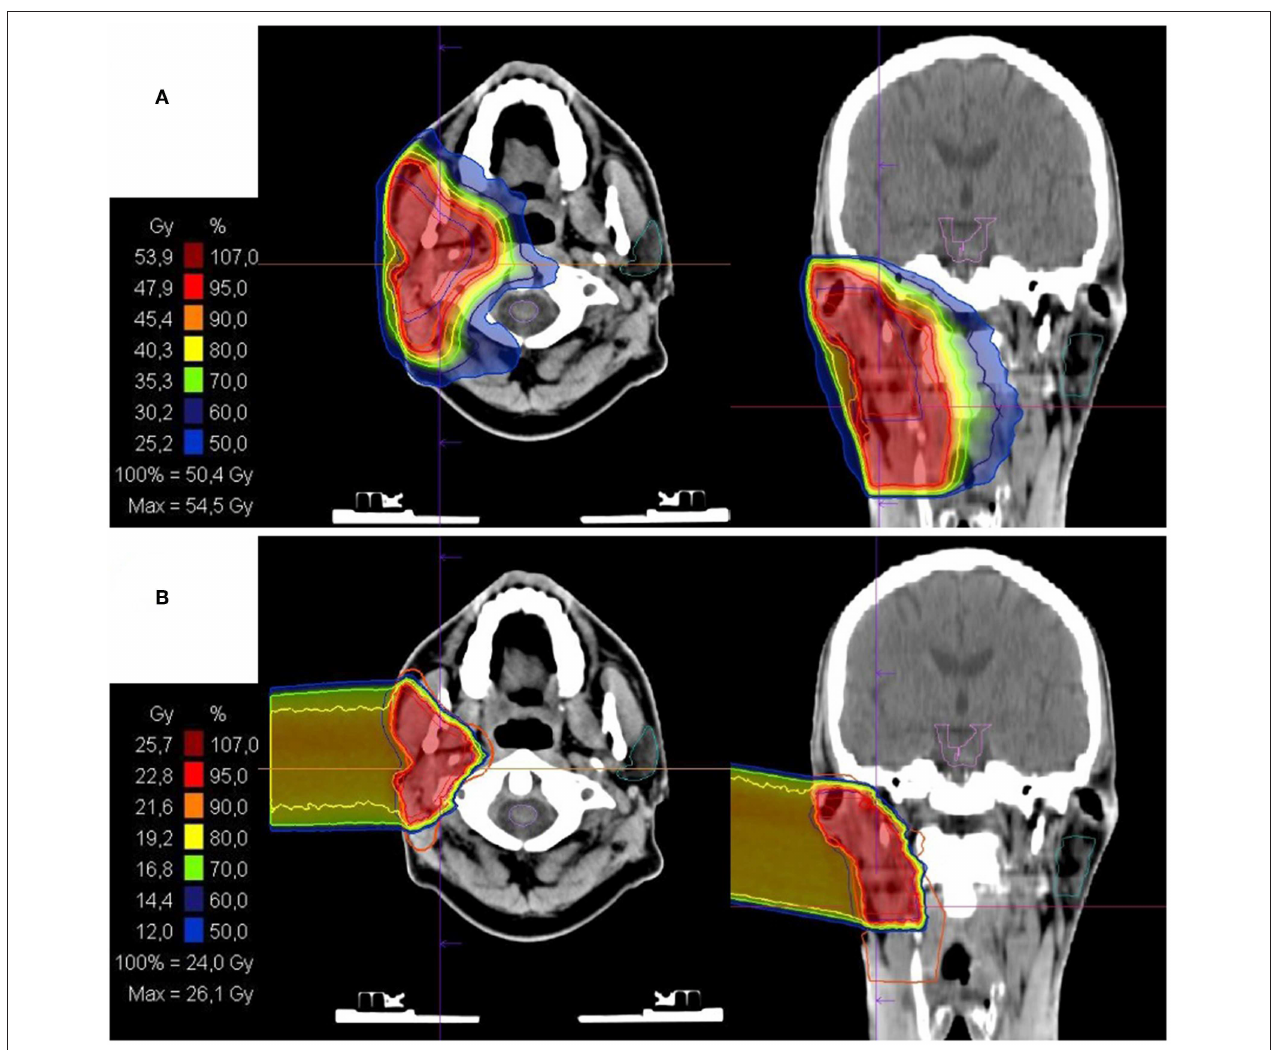
FIGURE 1 | Bimodal radiotherapy treatment plan: (A) intensity modulated radiotherapy (IMRT) base plan with 50Gy in 2Gy/fraction and (B) active raster-scanning carbon ion radiotherapy (CIRT) boost plan with 28Gy (RBE) in 3Gy (RBE)/fraction. Treatment was delivered as a definite radiotherapy in a patient with a recurrent rcT2 rcN2b cM0 salivary duct carcinoma (SDC) of the right parotid gland. CIRT was applied with one lateral beam. Histopathological work up revealed Her2neu and androgen receptor (AR) positivity. Therefore, the patient received an adjuvant therapy with trastuzumab and